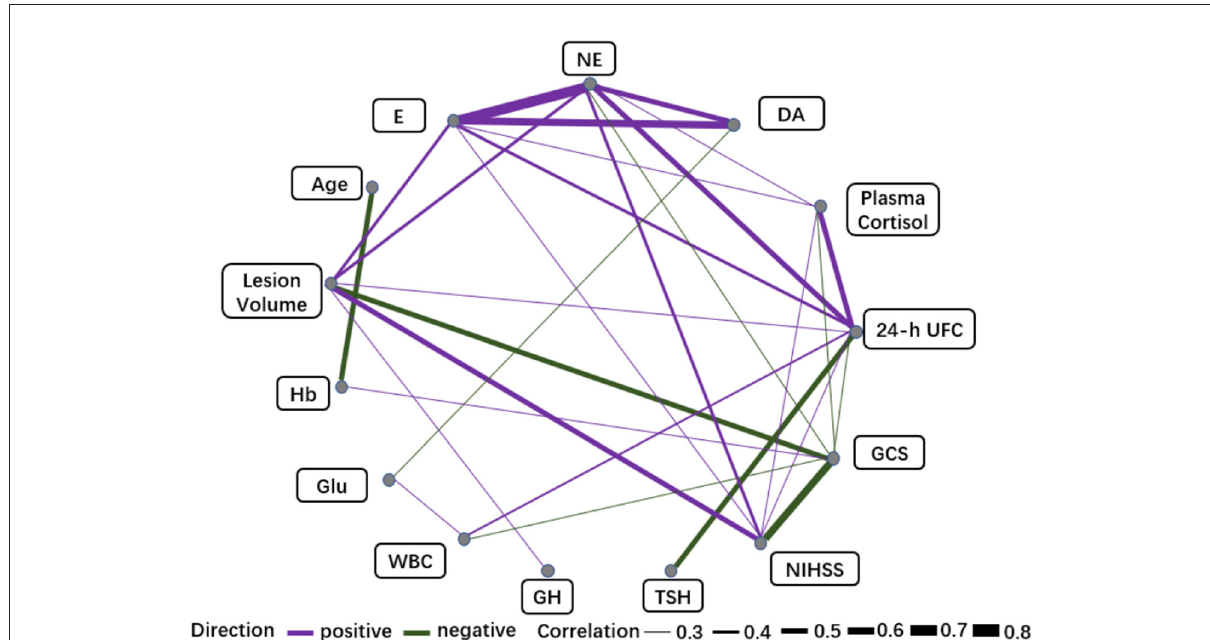
FIGURE4 Correlation networks for biomarkers (Day 1) and clinical variables. The width of the edge showing stronger or weaker interactions is proportional to the absolute value of biomarker-biomarker correlation (|r|). Edges are shown only when |r| > 0.3. A purple edge indicates a positive correlation, and a green edge indicates a negative